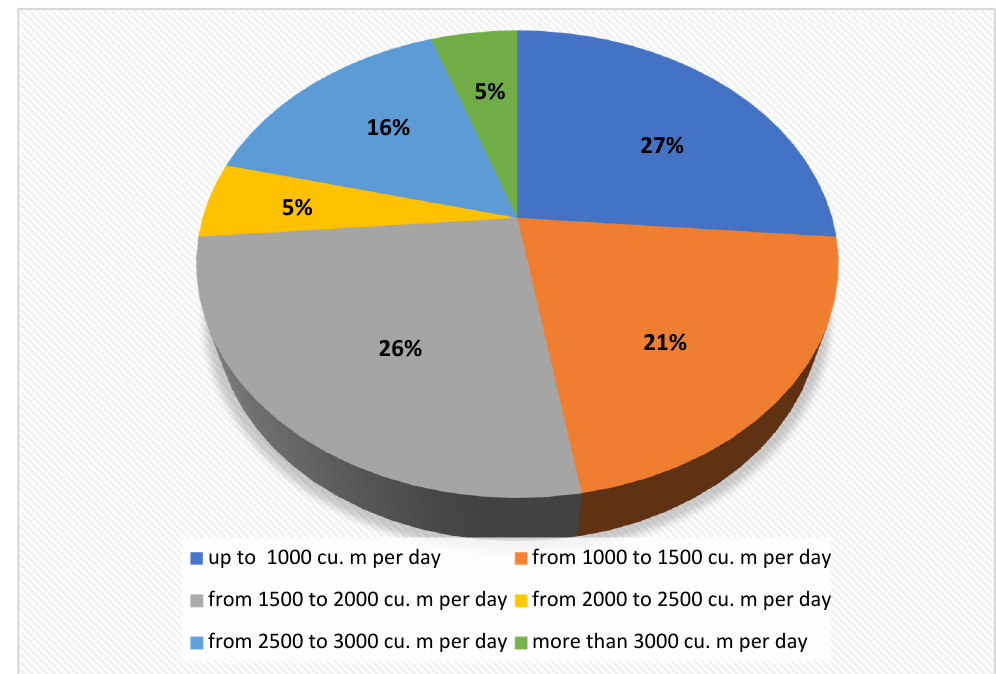
Figure 9. Waste slurry flow rates in analyzed projects (from Table 4).